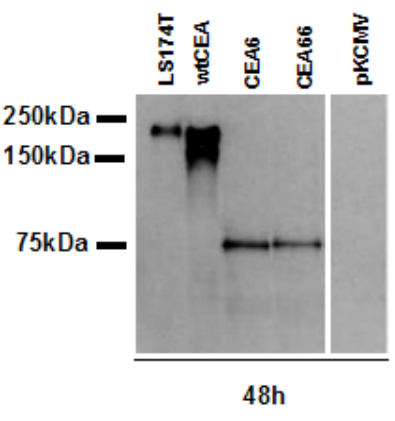
FIGURE 1. Expression of the CEA constructs . HEK 293 cells were transiently transfected with the different CEA constructs. At 48 h post-transfection, the cells were harvested and samples analyzed by western blot. CEA-specific bands were detected by chemiluminescence using a mouse antihuman CEA (DAKO clone II-7), as primary